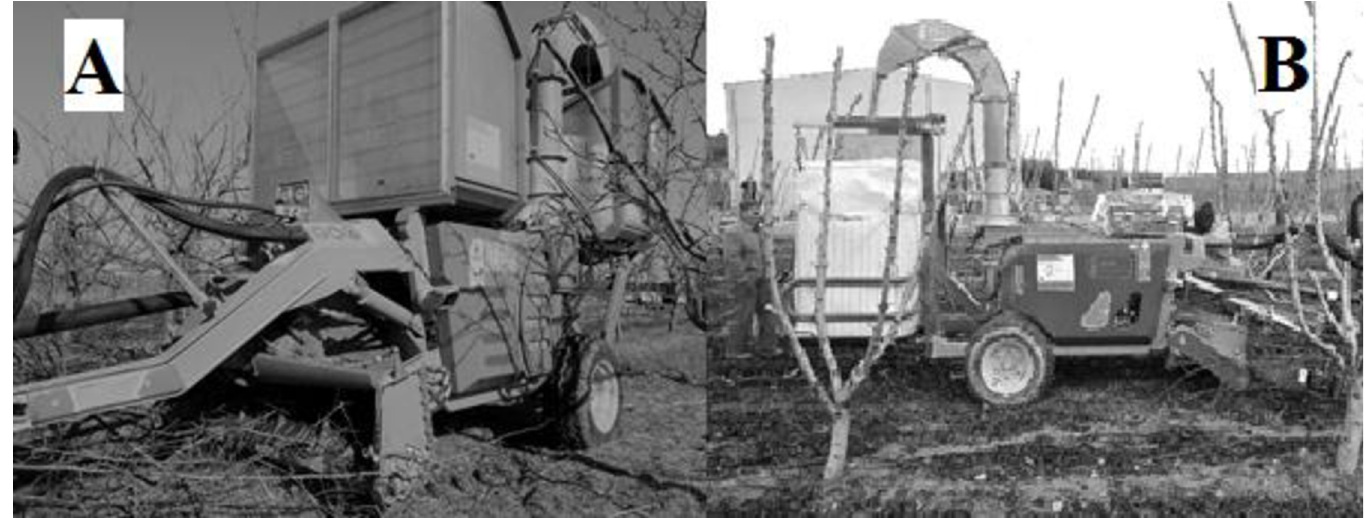
Fig 1. Naldoni prototype PC50 at different configuration. A) tilting box and B) big-bag during the harvesting.